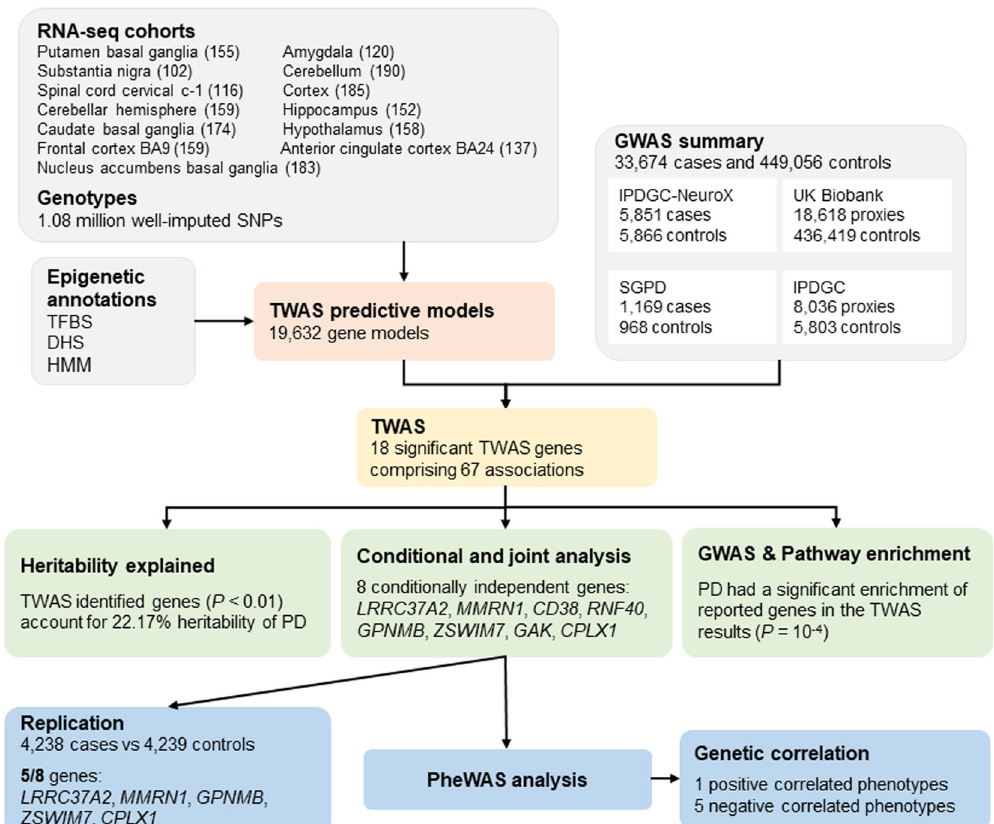
Fig. 1 The work fl ow of the study. GWAS, genome-wide association study; TFBS, transcription factor binding site; DHS, DNase I hypersensitive sites; HMM, chromatin state segmentation by hidden Markov model; TWAS, transcriptome-wide association study; PD, Parkinson ’ s disease; PheWAS, phenome-wide association